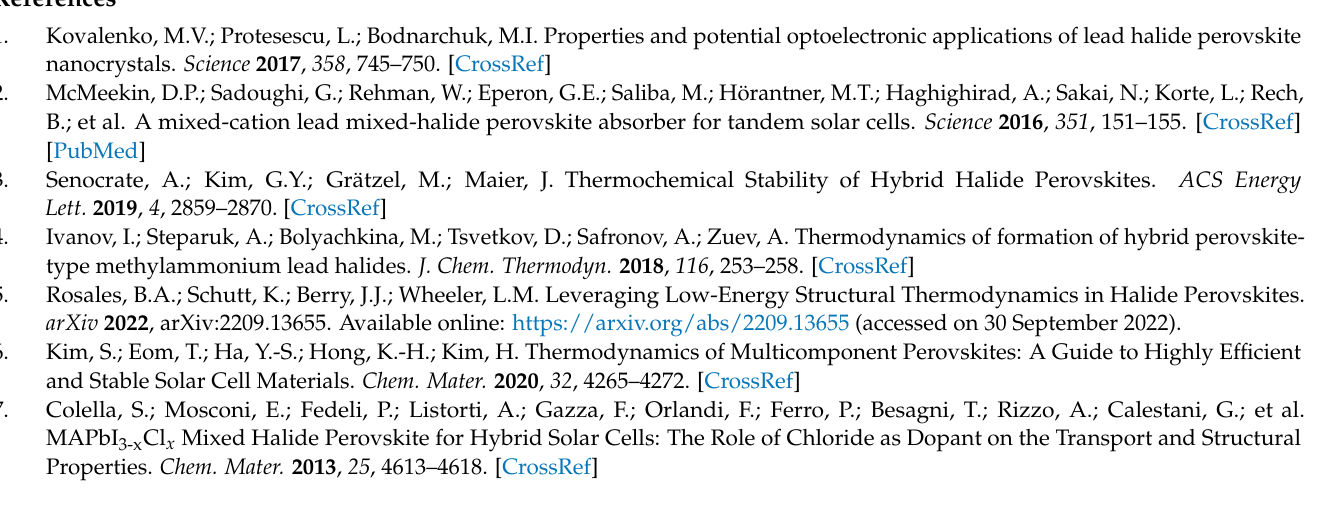
Table S2. Parameters of the Buckingham potential (Equation (S1)), used in this work and taken from [19]; Table S3. Parameters of the Lennard-Jones potential (Equation (S2)), used in this work; Table S4. Parameters of the harmonic bonds energy (Equation (S3)), used in this work and taken from [28]; Table S5. Parameters of the harmonic angles energy (Equation (S4)), used in this work and taken from [28]; Table S6. Partial charges, q , used in this work and taken from [19]; Table S7. Calculated and measured weight fractions of the elements in the synthesized solid solutions; Figures S1–S11: ters of the obtained solid solutions at T = 298 K, refined by Rietveld analysis of the PXRD patterns; and Table S9. The solution enthalpies of the solid solutions samples in dimethylsulfoxide (DMSO) at T = 298.15 K, p ◦ = 100